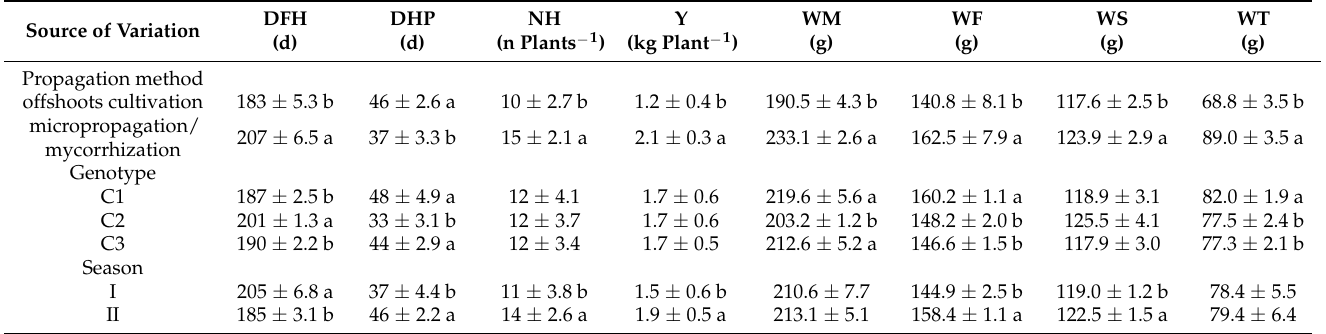
Table 3. Bio-agronomical characterization of the selected globe artichoke genotypes ( ± standard deviation) as affected by main factors under study. Different letters within the same parameter and main factor show significant differences among means (LSD test, p ≤